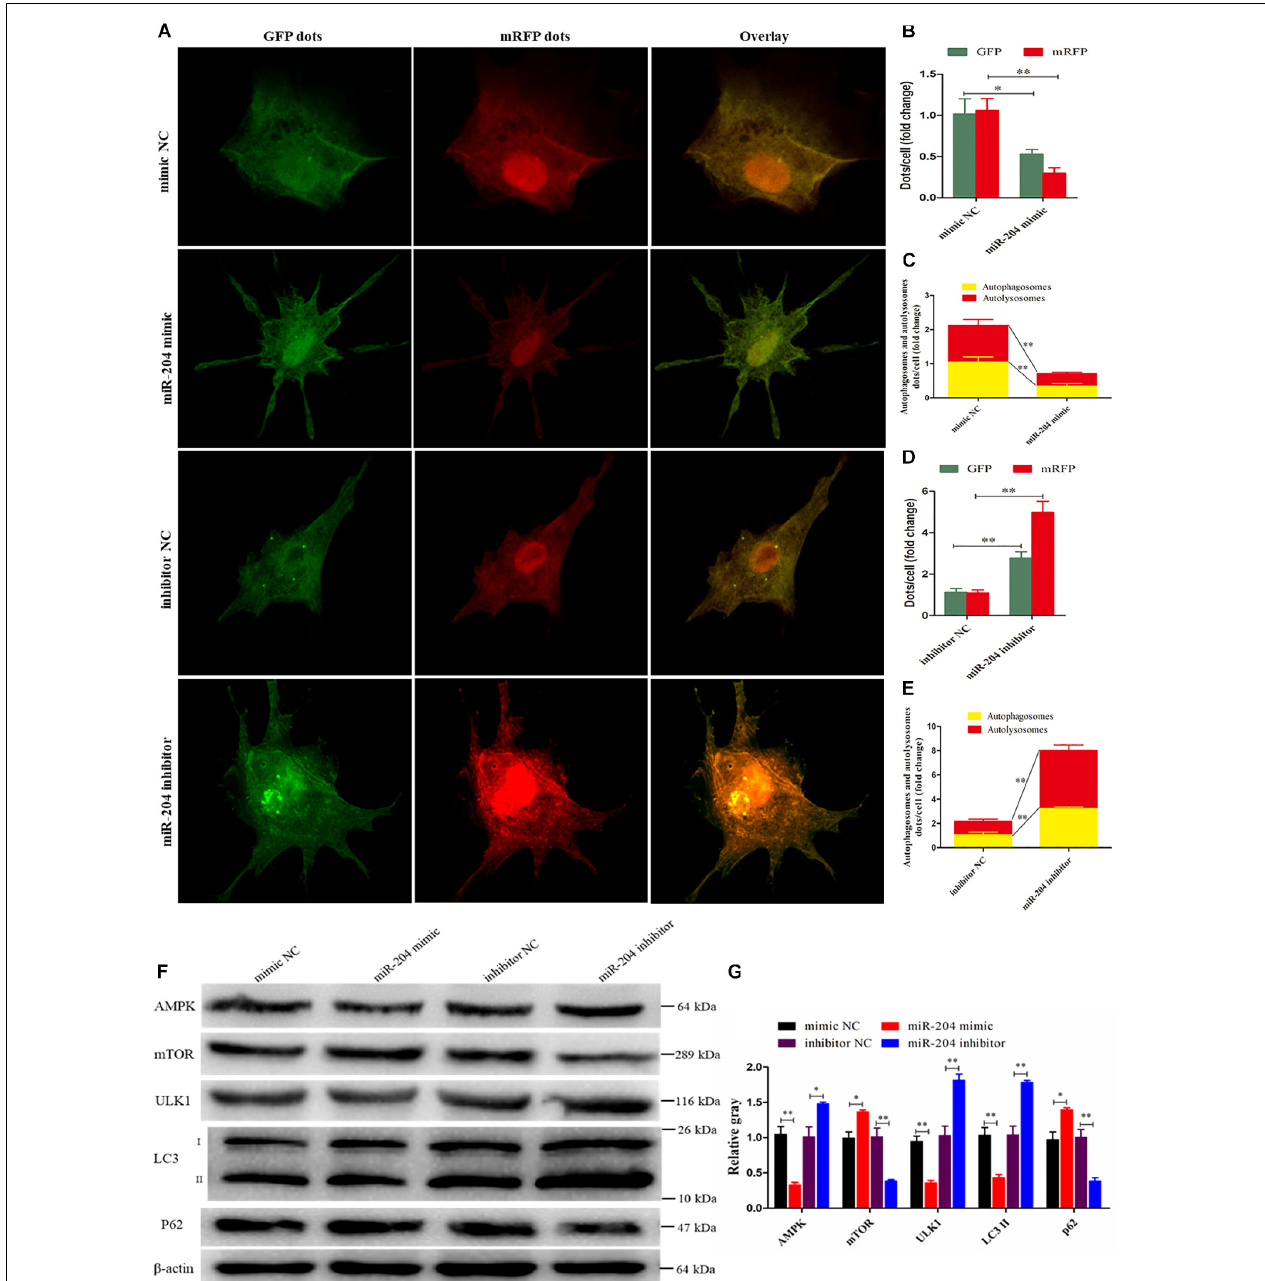
FIGURE 8 | miR-204 regulates granulosa cell (GC) autophagy via transient receptor potential melastatin 3 (TRPM3)/AMP-activated protein kinase (AMPK)/ULK1 pathway. (A) An adenovirus harboring tandem fluorescent mRFP-GFP-LC3 was used to evaluate the extent of autophagic flux after transfection of overexpression or inhibition of miR-204. (B, D) Mean number of green fluorescent protein (GFP) and monomeric red fluorescent protein (mRFP) dots per cell; nine cells were randomly selected to count for each field. (C, E) Mean number of autophagosomes and autolysosomes per cell. The autophagosomes were dotted with both green (GFP) and red (mRFP) color, and overlaid images showed with a yellow color. Autolysosomes were dotted with mRFP but not GFP, and overlaid images showed with a red color. (F, G) The protein levels of TRPM3/AMPK/ULK1 pathway [AMPK, mammalian target of rapamycin (mTOR), ULK, LC3-II, and p62] were detected after transfection of overexpression or inhibition of miR-204. β -actin was used as a reference gene. Replications = 3. Data are presented as mean ± SE; * P < 0.05 and ** P <